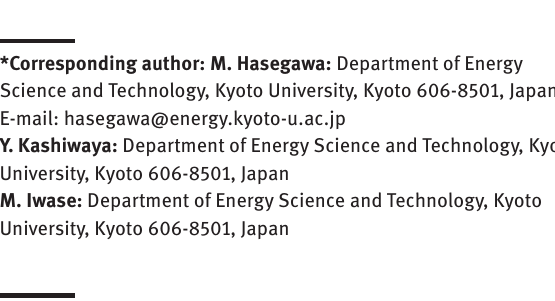
SiO -Ca P O 2 4 3 2 8